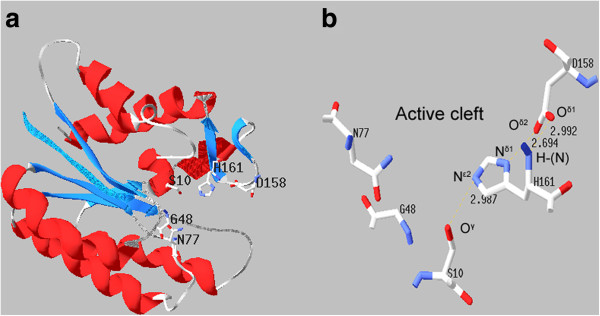
Three-dimensional structure of the recombinant ‘AcTesA.a) Overall structure of ‘AcTesA. The indicated residues are the catalytic triad, Ser10-Asp158-His161, and the stabilizing oxyanion residues, Gly48 and Asn77. b) Stereo view (Swiss-pdbviewer) of the catalytic triad and the oxyanion residues. The dashed lines indicate hydrogen bonding network, and the values represent the atom-atom distances.